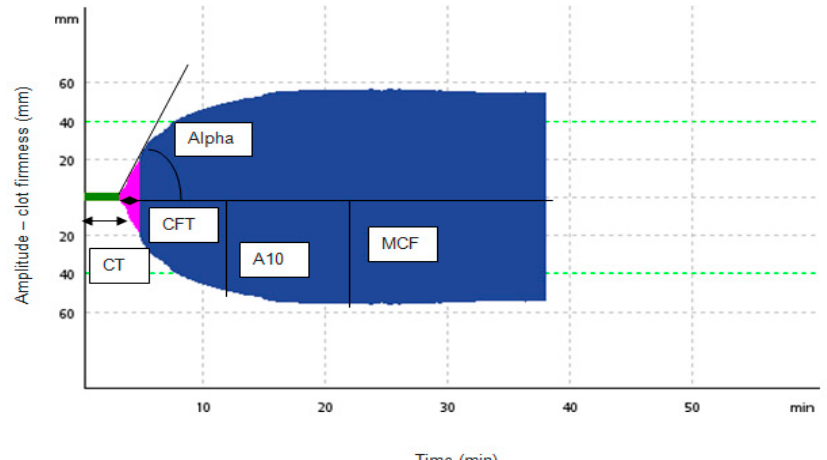
Figure 2. Selected ROTEM parameters. Legend: A10–amplitude at 10 min after CT, alpha—alpha angle (AA), CFT—clot formation time, CT—clotting time, MCF—maximum clot firmness (modified with the use of the authors’ data)